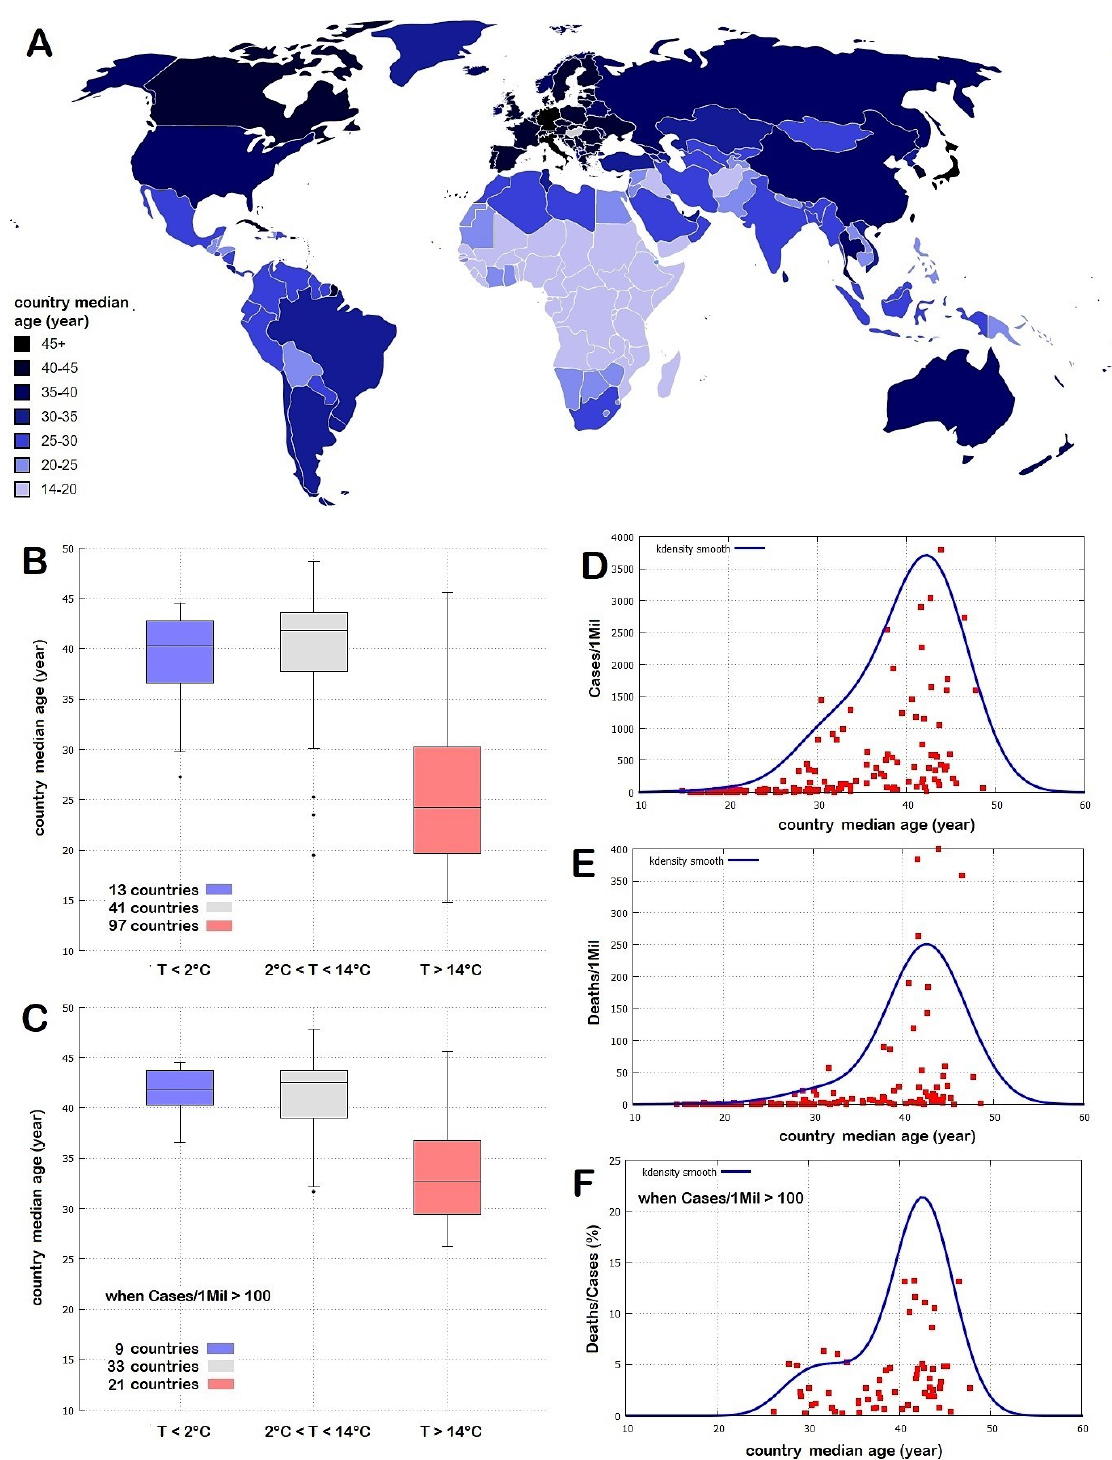
Figure 9. ( A ) World distribution of countries by mean population age. ( B , C ) distributions of countries by mean population age versus the climatic temperature zones depicted in Figure 8. ( D – F ) COVID-19 pandemic versus mean population of the